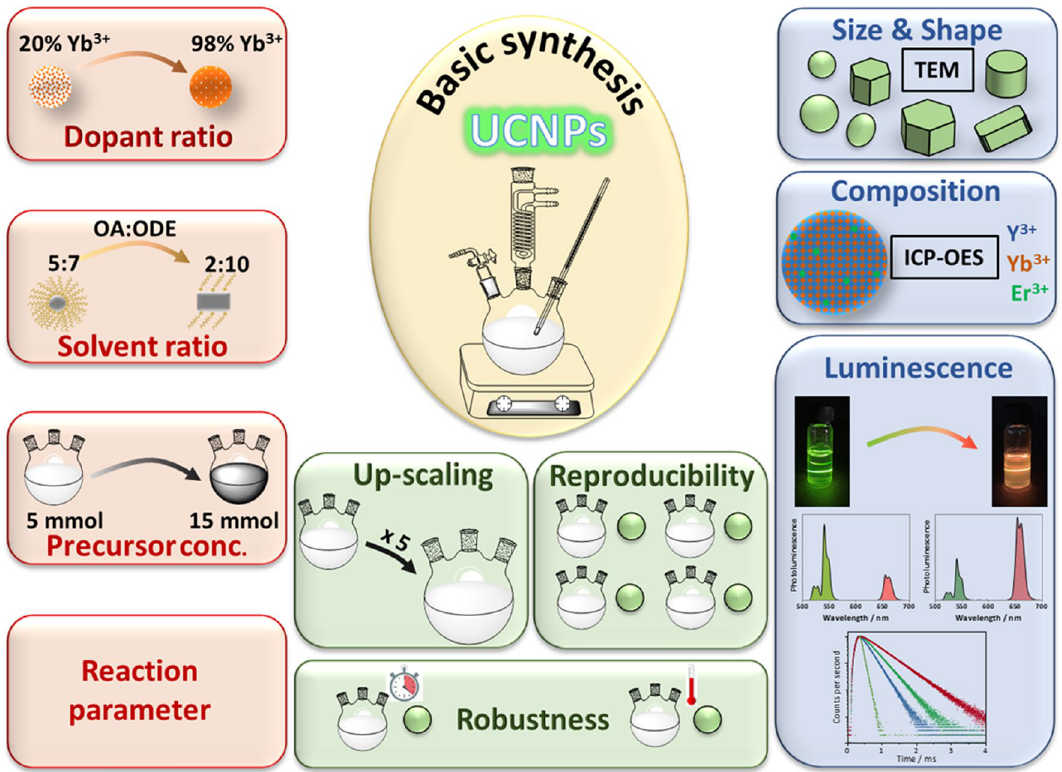
Figure 1. Schematic overview of the screening parameters (red, left) and the physio-chemical properties of the resulting UCNPs (blue, right) assessed for the basic synthetic approach with respect to reproducibility, robustness, and up-scaling potential (green, middle); OA , oleic acid, ODE 1-octadecene, Robustness reproducibility of UCNP properties as a function of or response to changes in reaction parameters such as temperature and reaction